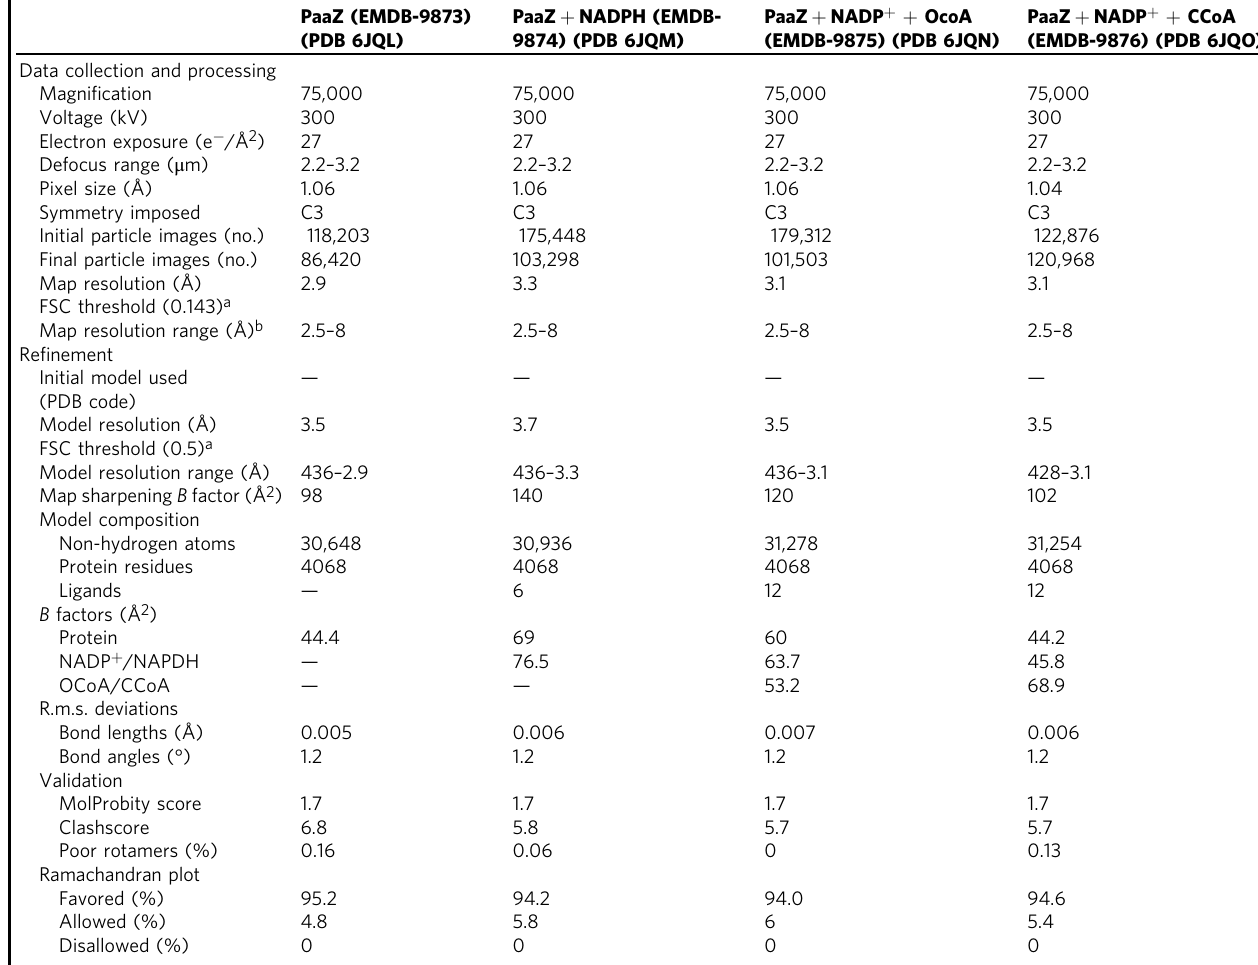
Table 1 Cryo-EM data collection, re fi nement and validation